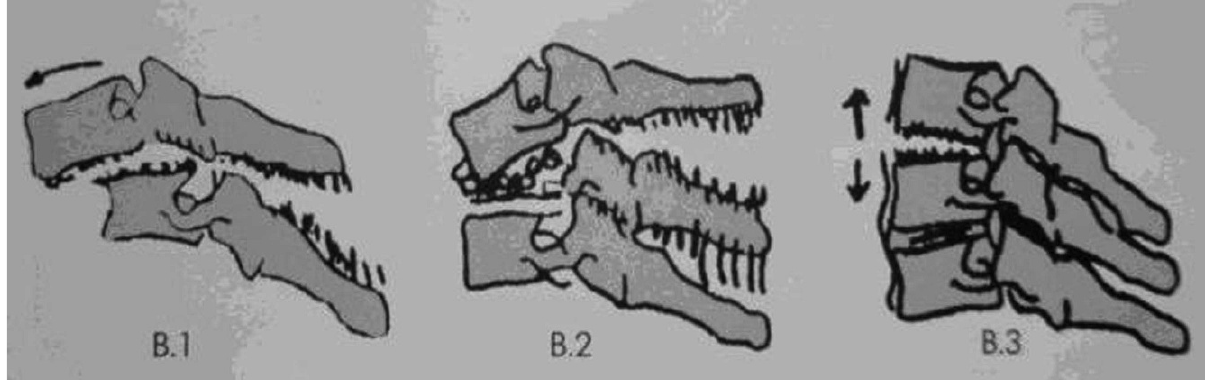
Figure 2 - AO classification. B distraction: B.1 = posterior distraction with vertebral body intact; B.2 = posterior distraction + fracture of the vertebral body; B.3 = anterior distraction +